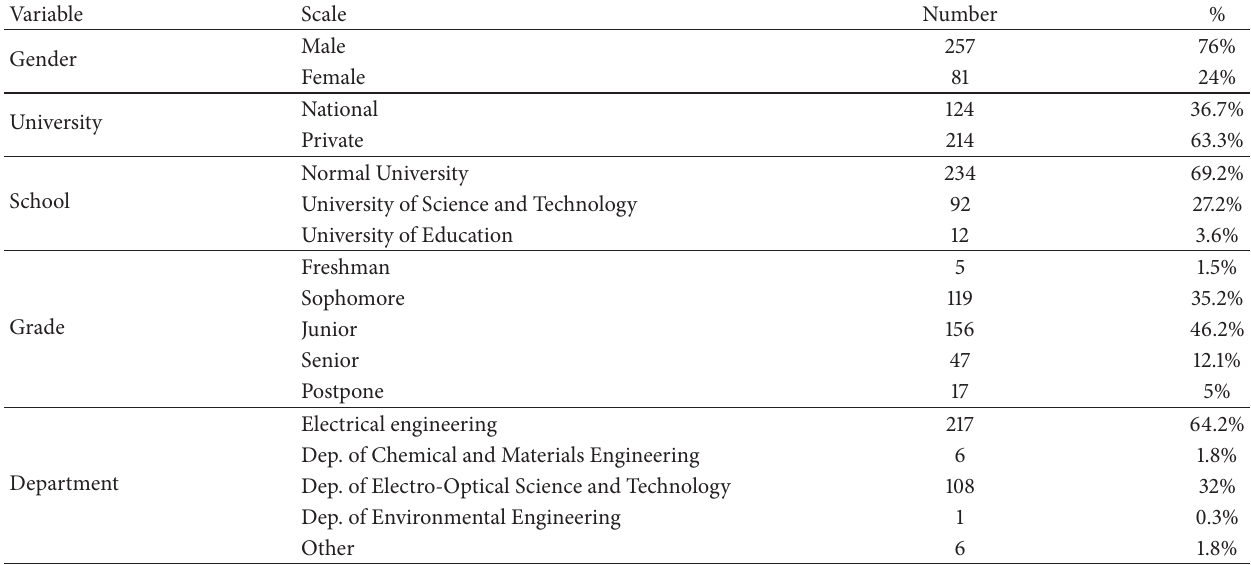
Table 2: Demographic data from universities respondents.